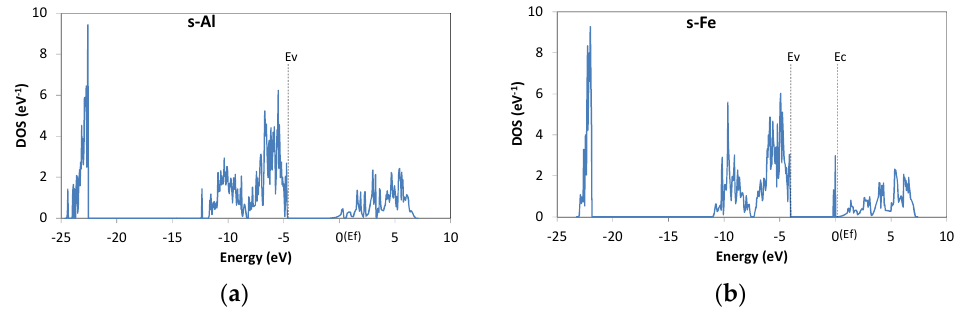
Figure 3. DOS of Mg(OH) 2 with a substitutional impurity. ( a ) Al; ( b ) Fe.